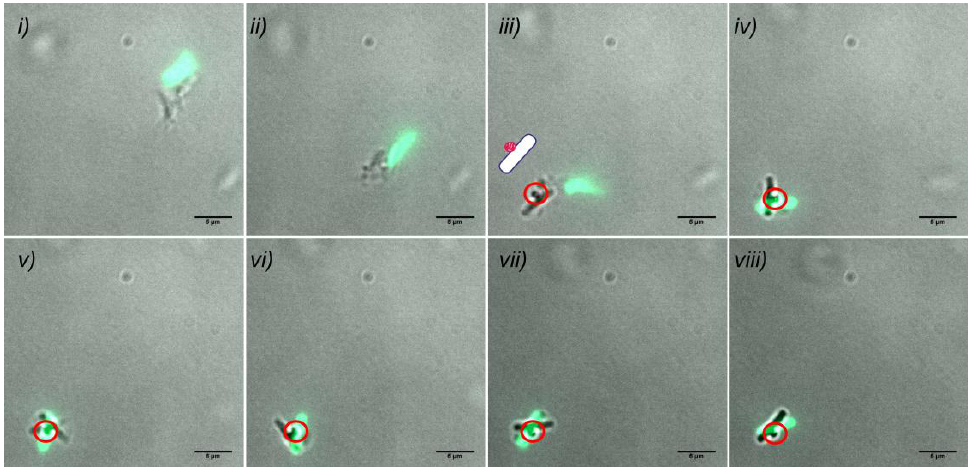
Figure 8. B. subtilis hybrid biosensor microswimmer. Merged images of green fluorescence and phase contrast time-lapse microscopy (8-frame time series, indicated i to viii ). The images illustrate the displacement of the freely swimming biosensor microswimmer P bceA -GFP (strain TMB2174) indicating the presence of bacitracin (18 µg mL− 1 ) in the surrounding media by the expression of green fluorescence, while carrying one inert cargo attached to its surface (the schematics of the Bacteria Bot composition is included in image ( iii ); the cargo is circled in red from ( iii ) to ( viii )). Note that due to technical limitations there is a delay between the phase contrast movement images and the fluorescence readout. The complete time-lapse series can be seen in Video S6 in the Supplementary Materials. Scale bar is 5 µm.